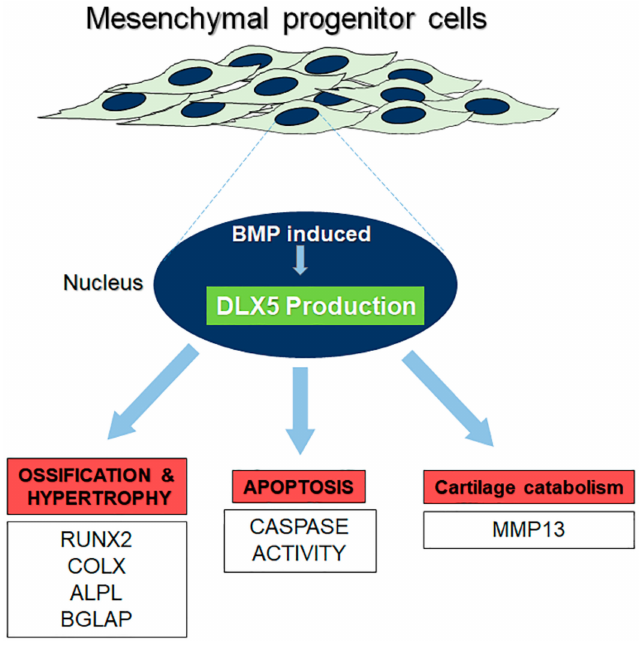
Figure 6. Proposed schematic of DLX5 function in mesenchymal progenitor